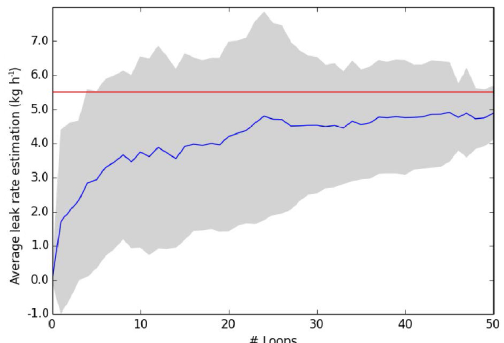
Figure 7. Averaged LES estimates for the Aerodyne case. This leak shows a slightly higher number of laps before convergence ( ∼ 25 laps). This simulation was performed using the conditions for the Aerodyne controlled release near Denver, Colorado, on 19 November